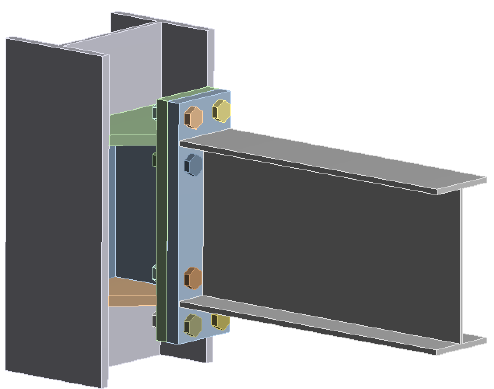
Figure 1. View of a weak-axis moment connection.